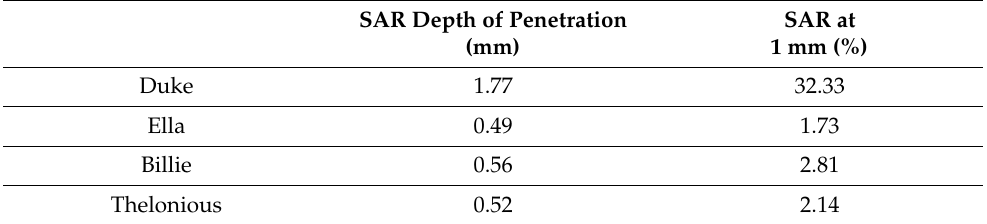
Table 3. SAR depth of penetration and SAR at 1 mm depth (in % with respect to the peak value) for the phone call